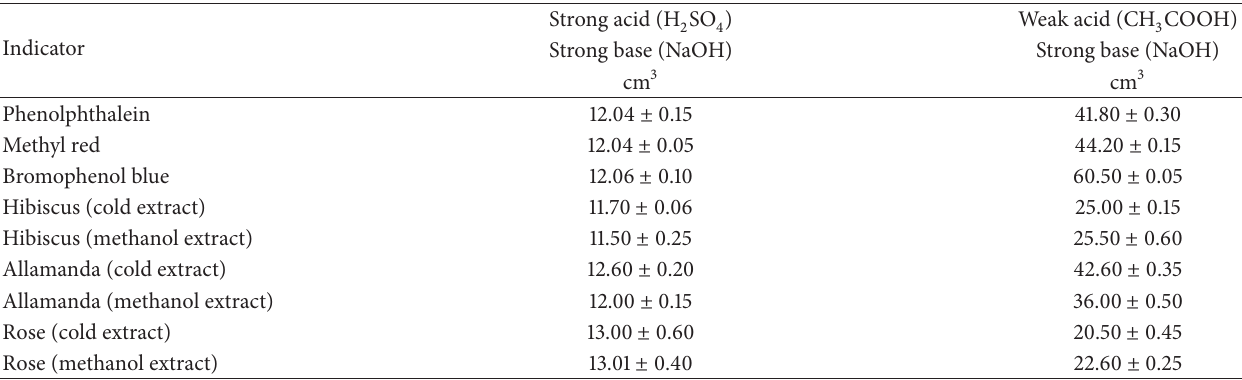
Table 8: Acid-base titration with extract as indicator.